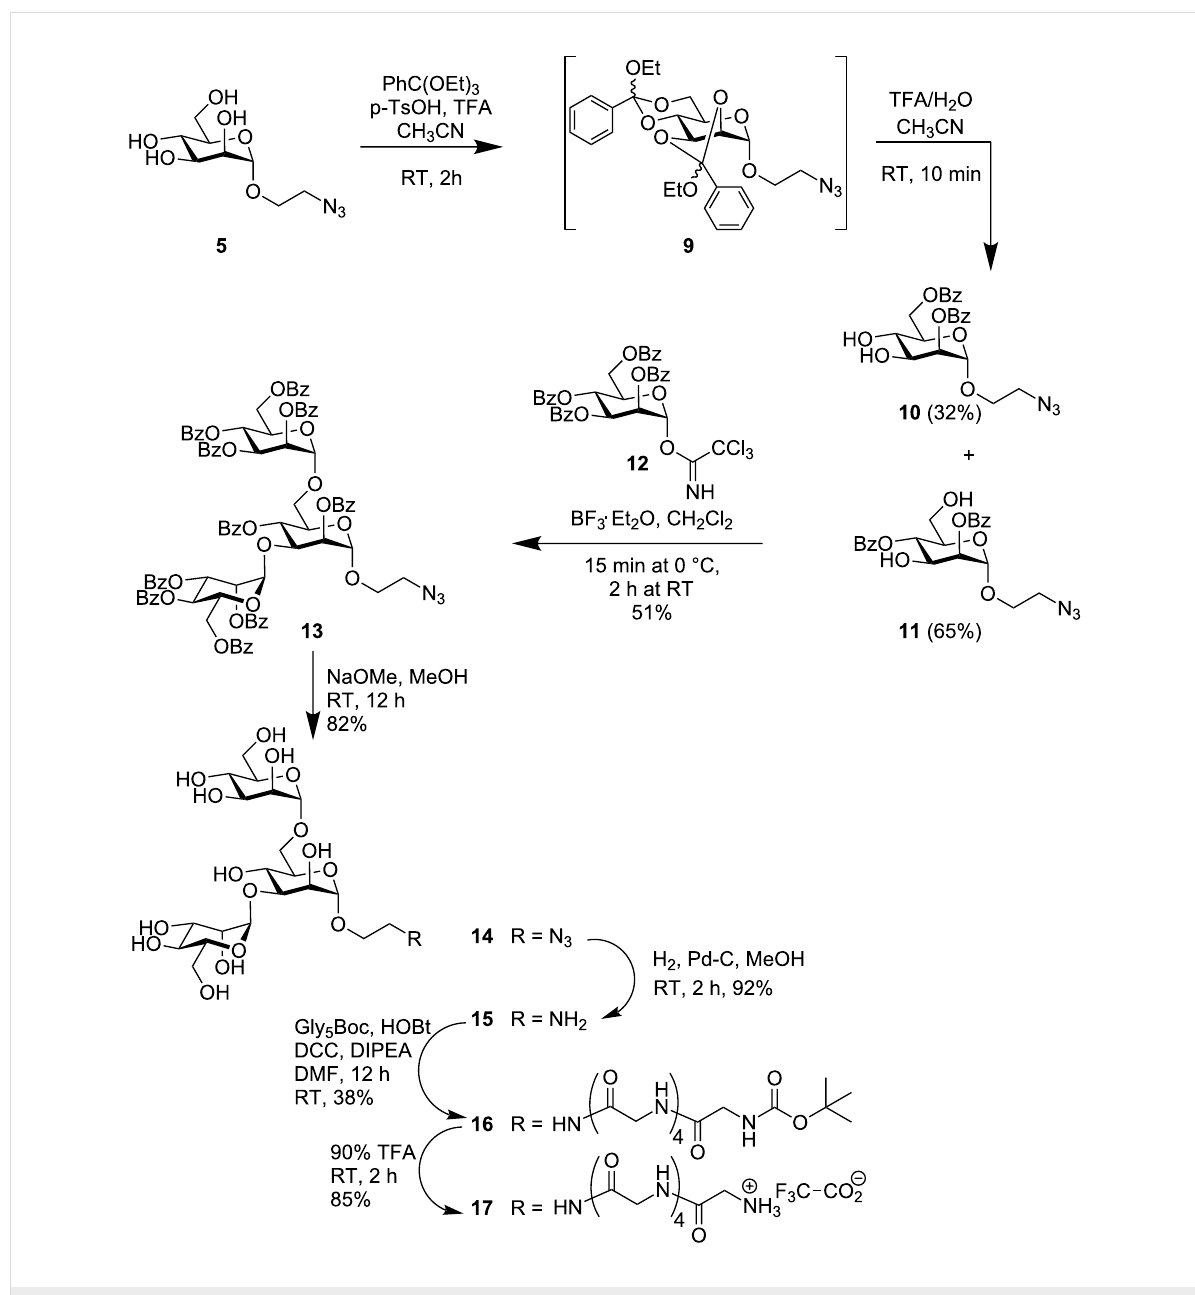
Scheme 2: Synthesis of the western part of target molecule 1